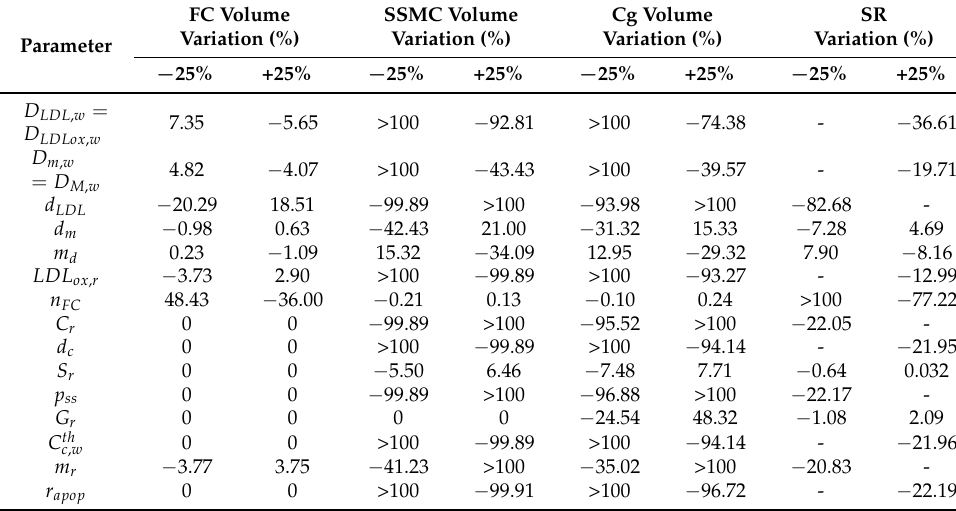
Table 6. Results of foam cells, synthetic smooth muscle cells, and collagen volume variations (second, third, and fourth columns, respectively), and stenosis ratio variation (fifth column), by reducing and increasing the values of the parameters of the first column by